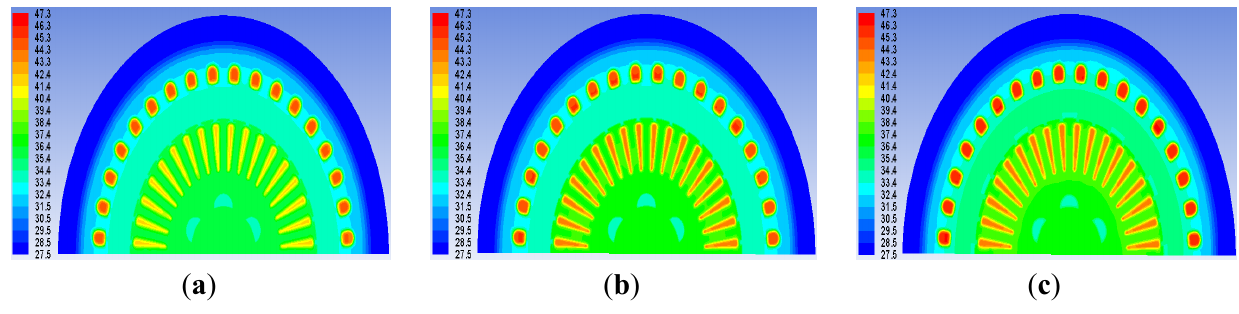
Figure 20. Thermal field distribution of three cross-sections: ( a ) the windward side; ( b ) the middle cross-section; and ( c ) the leeward